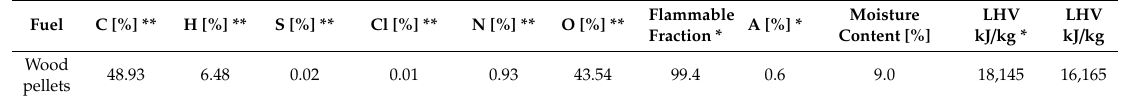
Table 1. Fuel properties of wood